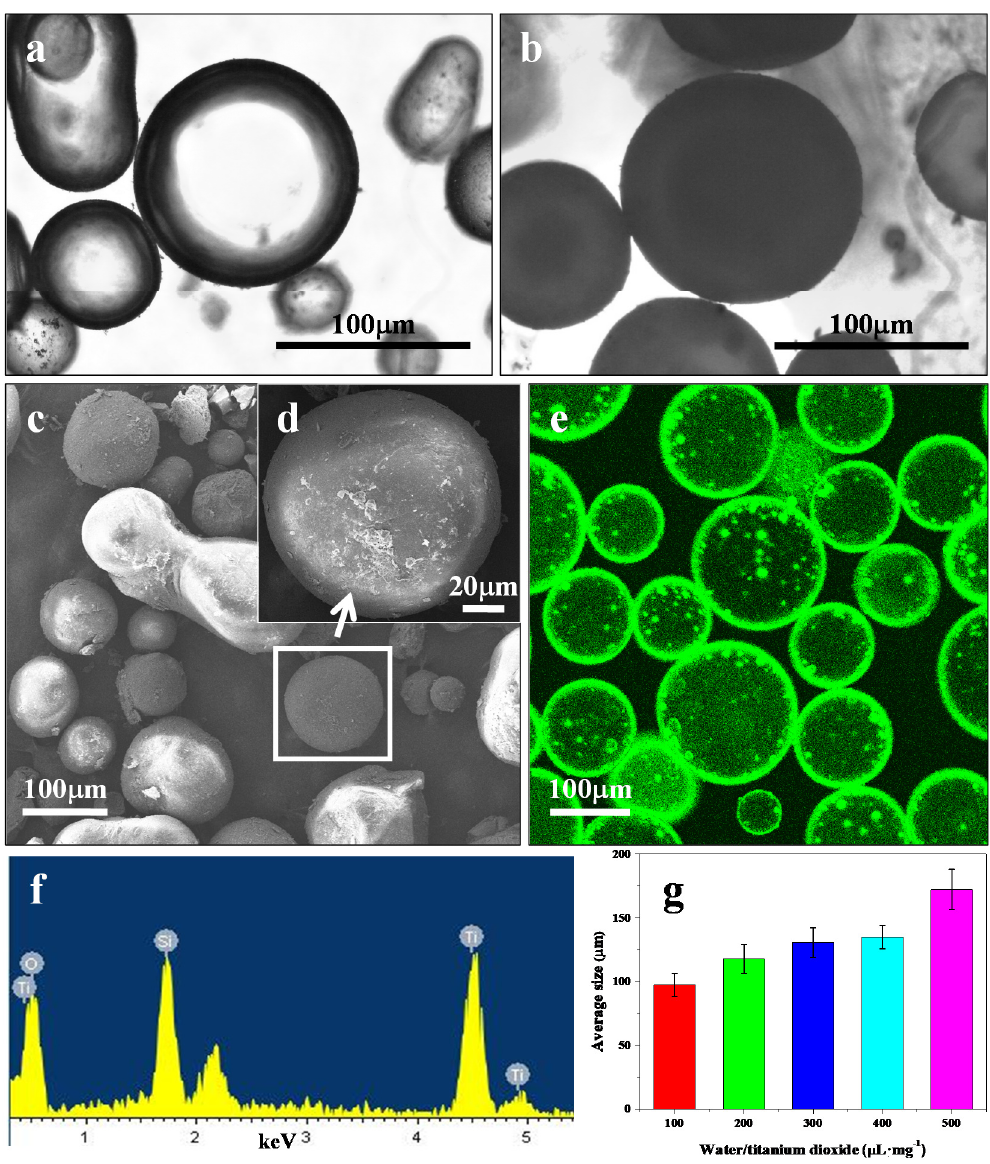
Figure 2. Microscopic images of the ADH@TiO 2 NP microreactors. ( a , b ) Optical images; ( c , d ) SEM images; and ( e ) CLSM image. ( a ) Water-in-oil Pickering emulsions before being cross-linked by TEOS; ( b ) Water-in-water microcapsules after being cross-linked by TEOS; ( c , d ) SEM images of the dried ADH@TiO 2 NP microreactors; ( e ) CLSM image of the FITC labeled ADH@TiO 2 NP microreactors; ( f ) EDS analysis of the ADH@TiO 2 NP microreactors; ( g ) Average size distributions, median values, and standard deviations were calculated by fitting Gaussian functions to the histograms.